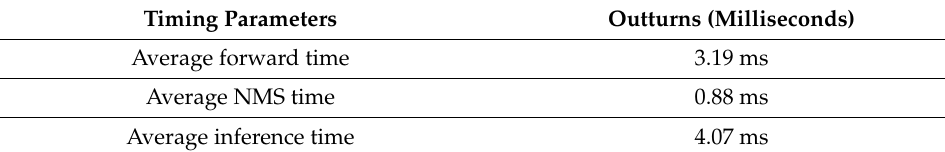
Table 7. Time results of the trained model.